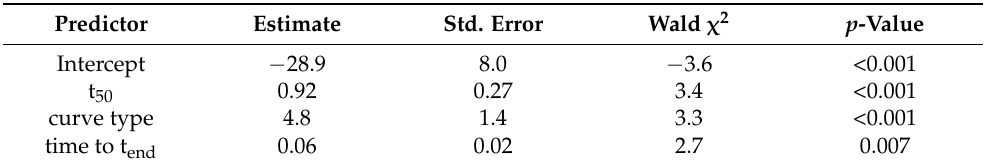
Table 4. The new prediction model based on the patients diagnosed with Raynaud’s phenomenon by the clinical evaluation ( n = 26) and the healthy controls ( n = 57). Estimates are the respective coefficients of the model with the associated standard errors. The p - values show the predictors’ respective contributions to the